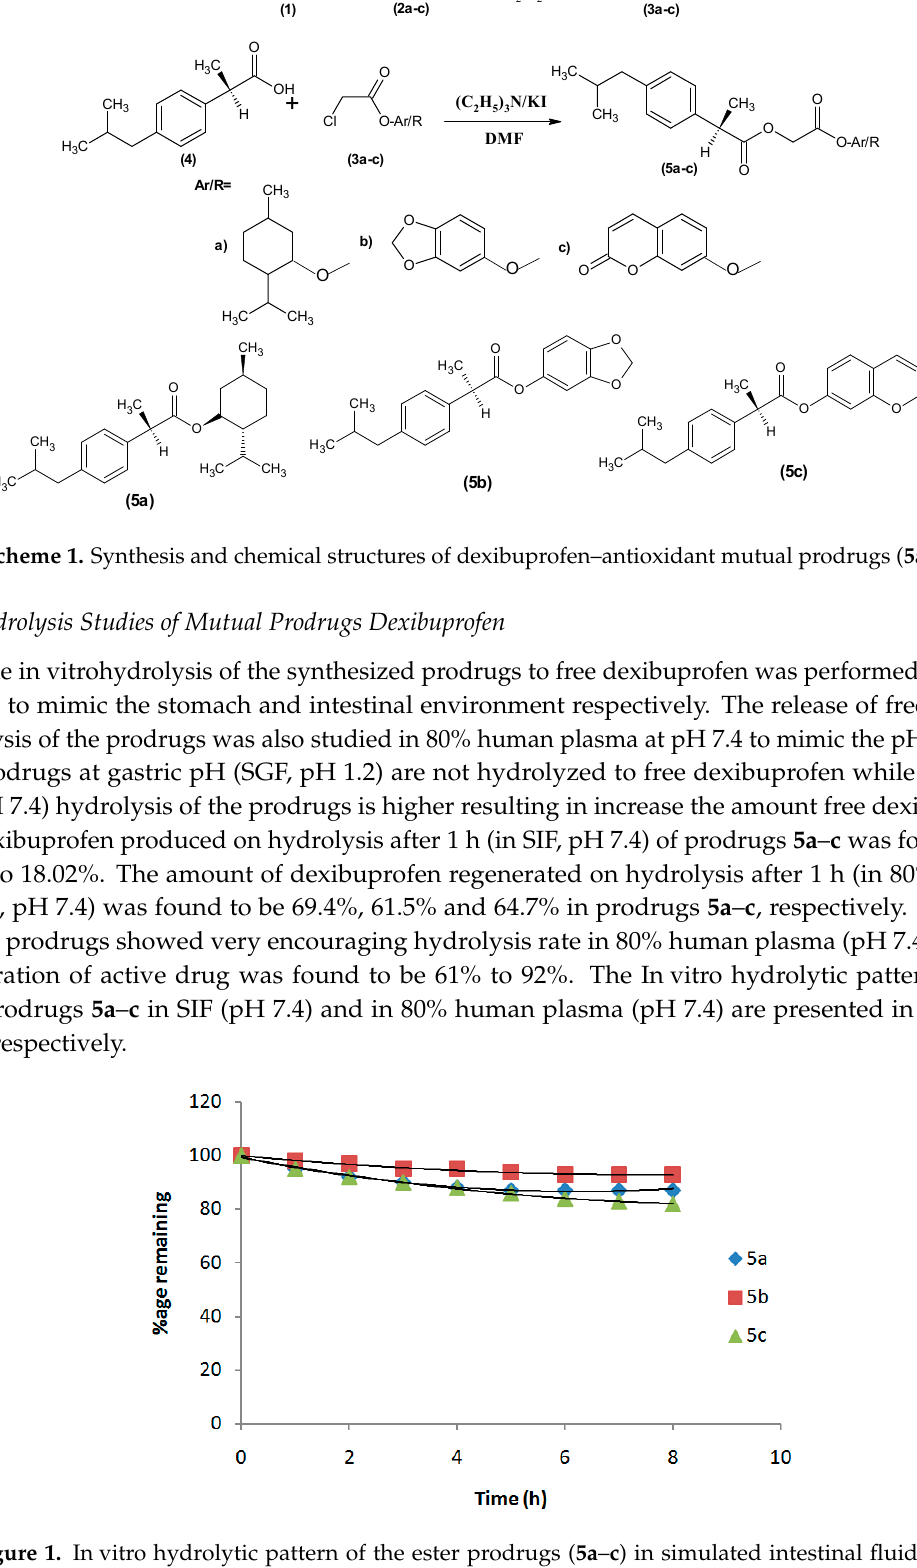
Figure 2. In vitro hydrolytic pattern of the ester prodrugs ( 5a – c ) in 80% human plasma (pH 7.4). 2.3. Pharmacology Anti-Inflammatory Activity Anti-inflammatory activity results confirmed that there was a gradual increase in paw volume of mice in the control group. However, in the treated groups, all prodrugs 5a – c produced a significant reduction in edema formation. The prodrug 5c exhibited anti-inflammatory effects by significantly ( p < 0.001) inhibiting the paw-edema at 4 h of post carrageenan induced inflammation with percentage inhibition of (28.99%). However, prodrugs 5a and 5b produced comparatively less anti-inflammatory response ( p < 0.01) than standard dexibuprofen (Tables 1 and 2). Carrageenan induce edema in bi-phase, the duration of first phase is 0–2.5 h post injection of agent. During this phase, different inflammatory mediators such as histamine, serotonin and bradykinin are released that cause vasodilation [21], whereas during the second phase inflammatory mediators such as